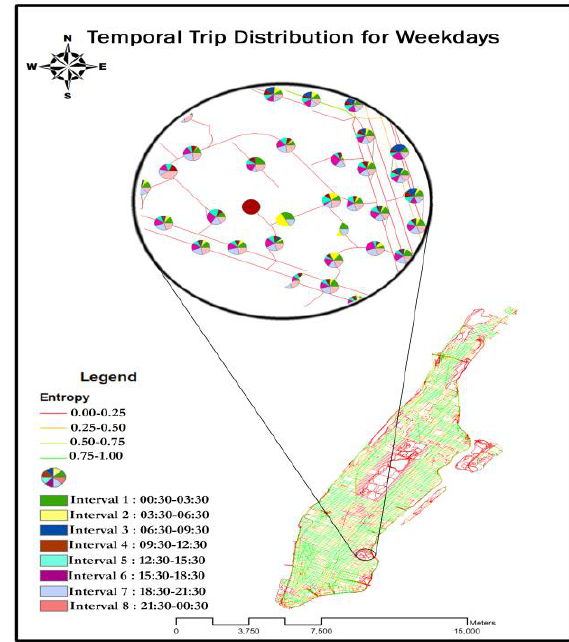
Figure 8. Trip Distribution for Low Entropy